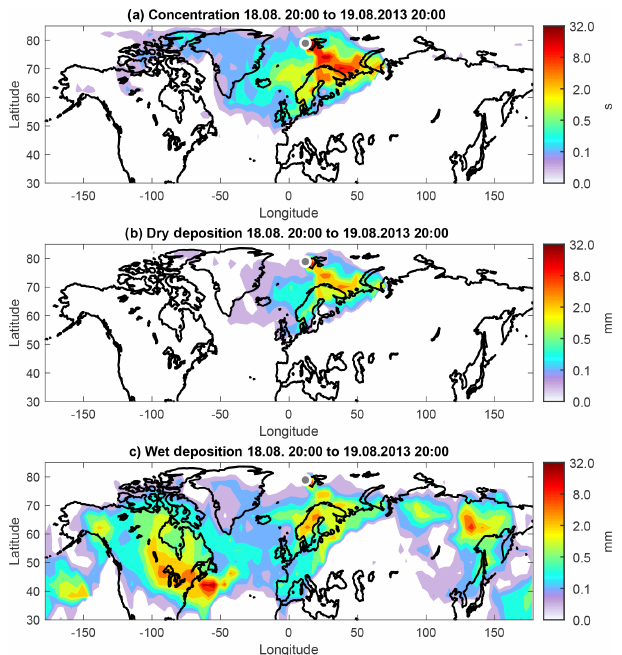
Figure 3. Source–receptor relationships (for emissions occurring in the lowest 100ma.g.l.) for black carbon observed at Ny-Ålesund in Svalbard for a 24h period starting on 18 August 2013 at 20:00UTC. The sensitivities were calculated for (a) concentrations (s) in the layer 0–100ma.g.l., (b) dry deposition (mm) and (c) wet deposition